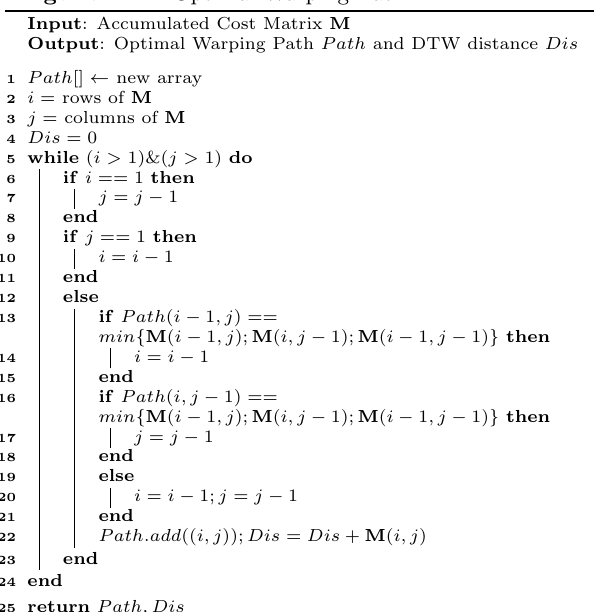
Algorithm 2: Optimal Warping